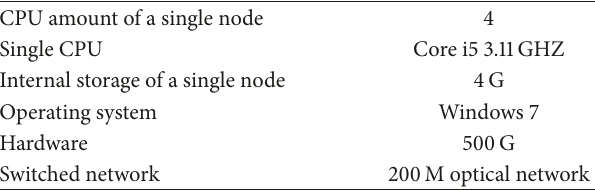
Table 2: Parameters of the simulation experiments. CPU amount of a single node